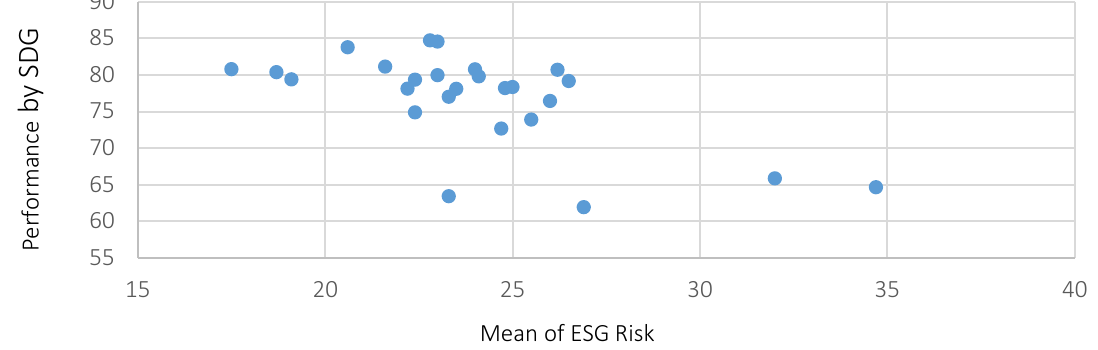
Figure 1. Correlation for 26 countries between indicators performance by SDG and mean of ESG Risk